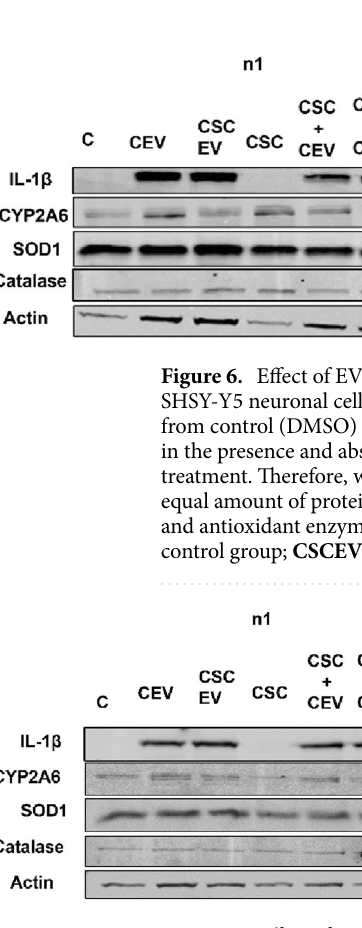
EVs of HIV-infected subjects than their plasma and non-infected subjects 60 .